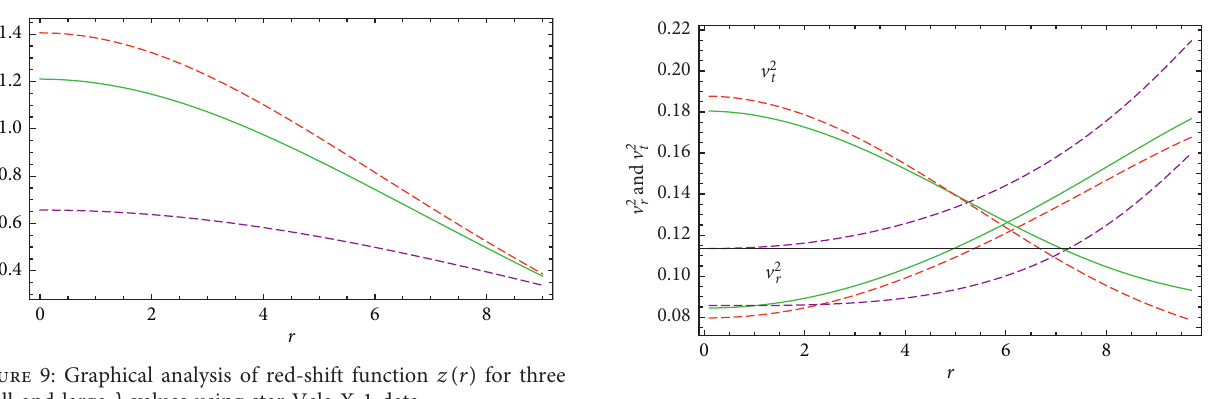
v 2 � 0 . 25, 4, and 10 for r and t for λ